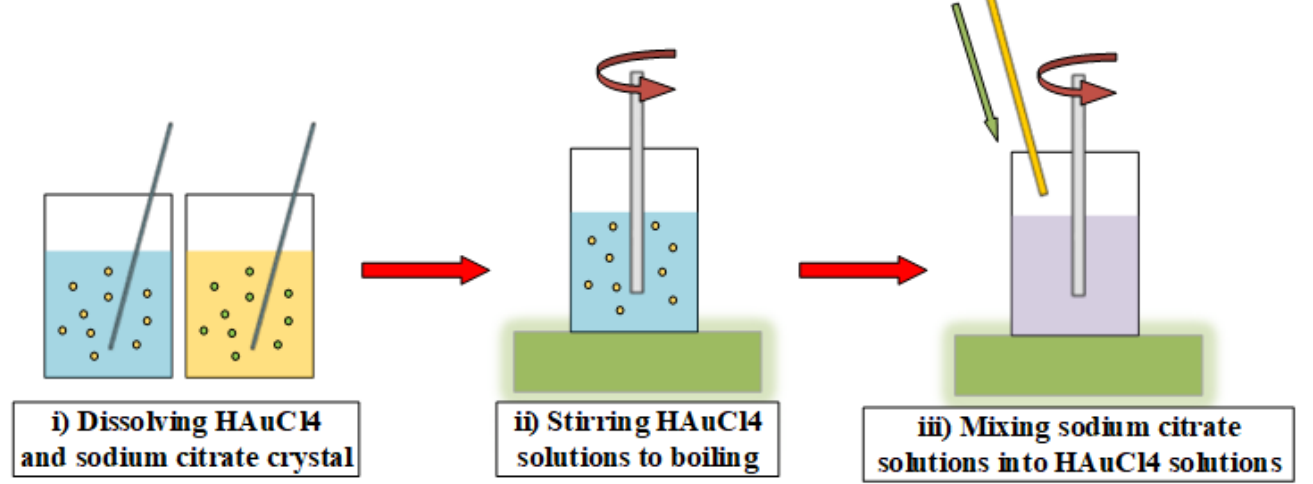
Figure 1. One-step method for preparing the gold nanofluids.